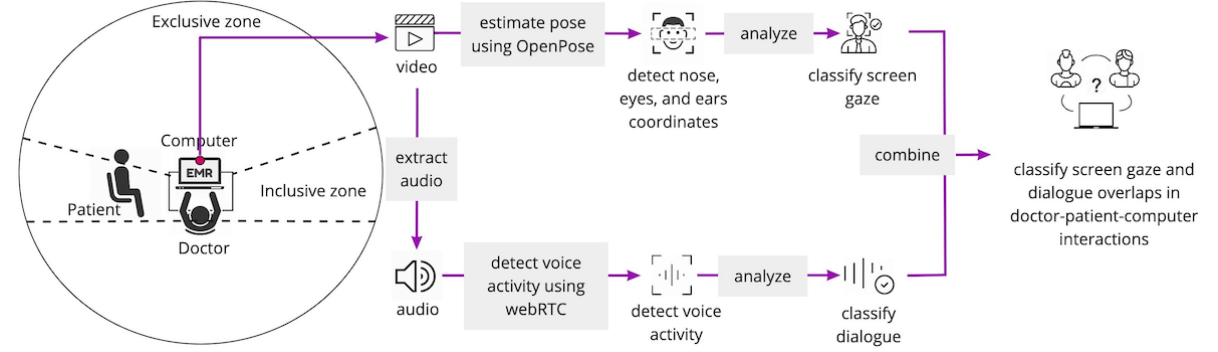
Figure 1. Overview of the classification process. EMR: electronic medical